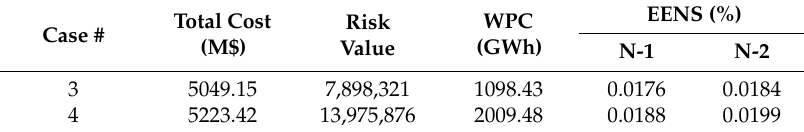
Figure 11. CC distributions for cases 3 and 4 with increasing wind power for the Polish 2383-bus system. Table 7. Results comparison for cases 3 and 4 with 10% wind power for the Polish 2383-bus system.